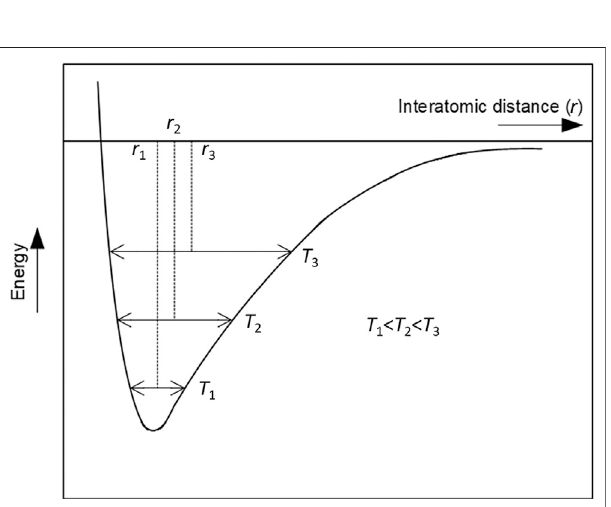
FIGURE 3 | Schematic representation of an asymmetric interatomic potential well. The positions r 1 , r 2 and r 3 show the evolution of mean interatomic distances with increasing temperature, with the mean interatomic distance increasing with increasing temperature as in normal (positive) thermal expansion.